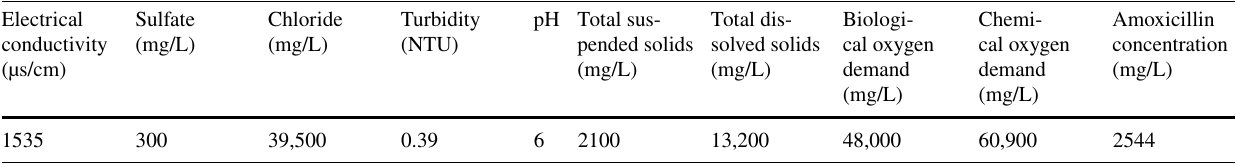
Table 1 Physiochemical quality of the wastewater of Dana pharmaceutical factory Electrical conductivity